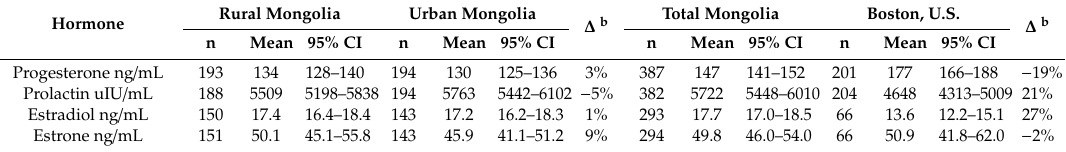
Table 2. Hormone Concentrations a in Women Living in Rural and Urban Mongolia and Boston, U.S.